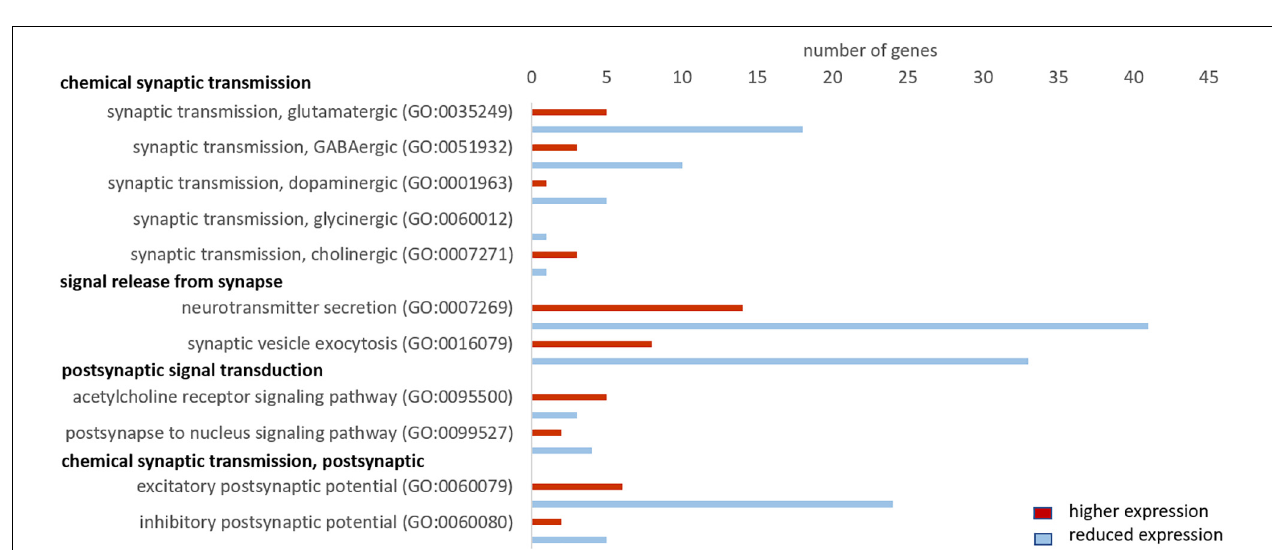
FIGURE 3 | Enriched GO-slim terms in the category “biological processes” in the neurons of the visual cortex of hooded seals compared to mice. Genes used for analysis were significantly less expressed in hooded seals (fold change ≤ –2). The number of hooded seal genes in every GO-slim term and the FDR-corrected p -value are presented.